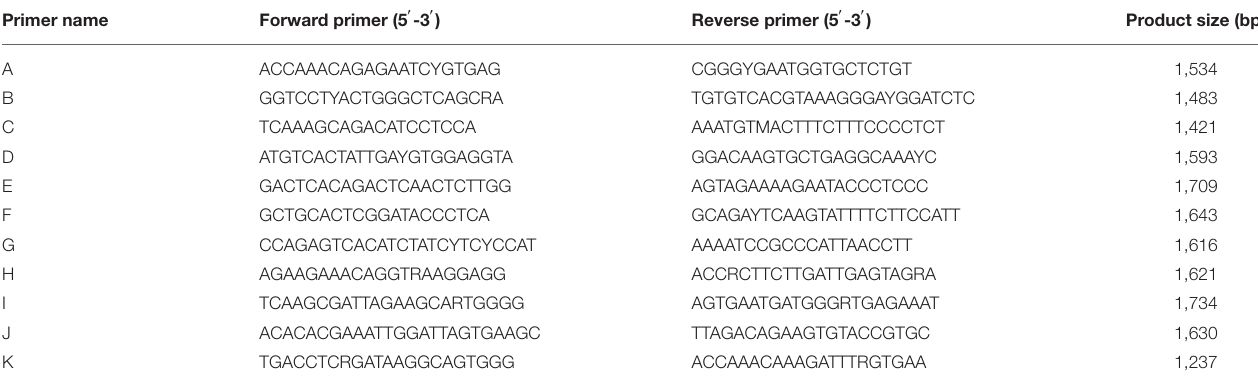
TABLE 2 | Universal Primers for the amplification of the whole genome of PPMV-1